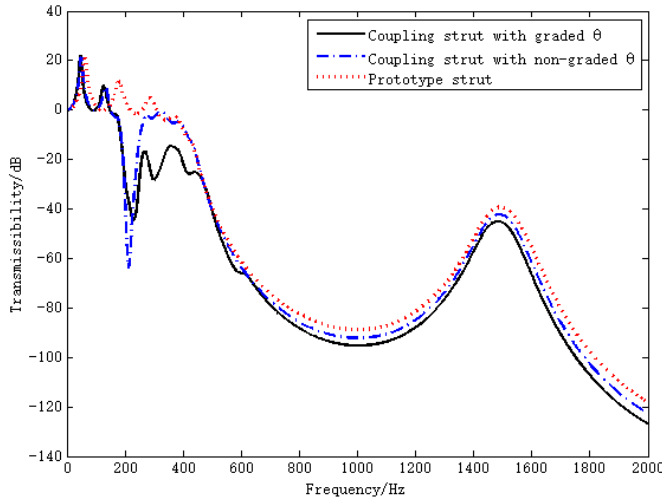
Figure 13. Transmission capability of the three types of struts when =0.1 δ .